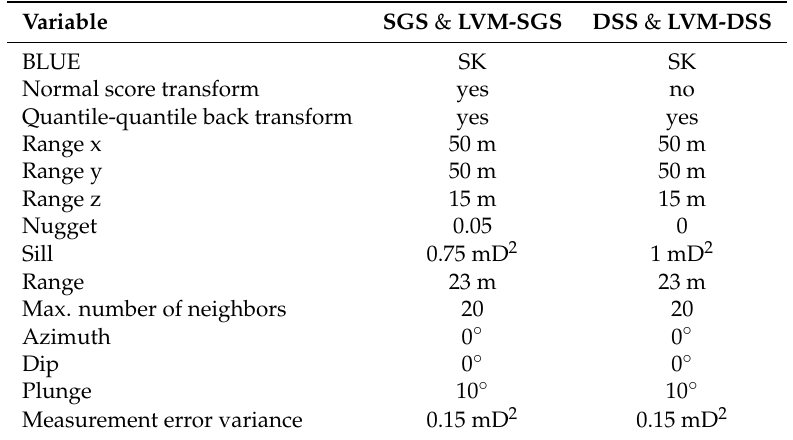
Figure 9. ( a ) Simple kriging estimate ( b ) and the local simple kriging variance for one SK realization. Table 2. Modeling variables for the sequential